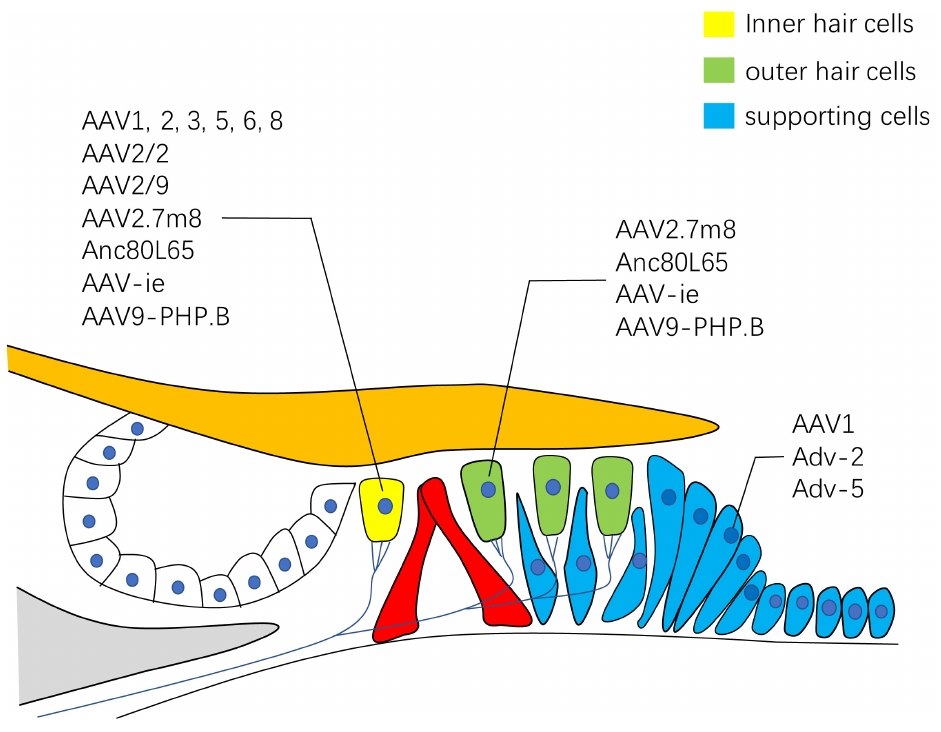
Figure 1. Viral vectors with specific transfection efficiency for different target cells. Studies have shown that AAV2.7m8, Anc80L65, AAV-ie, AAV9-PHP.B have high transfection efficiency in both inner hair cells and outer hair cells; AAV1 , 2, 3, 5, 6, 8 , AAV2/2, AAV2/9 also have higher transfection efficiency in inner hair cells, AAV1, Adv-2, Adv-5 have higher transfection efficiency in supporting cells; Adv: Adenovirus; AAV: adeno-associated